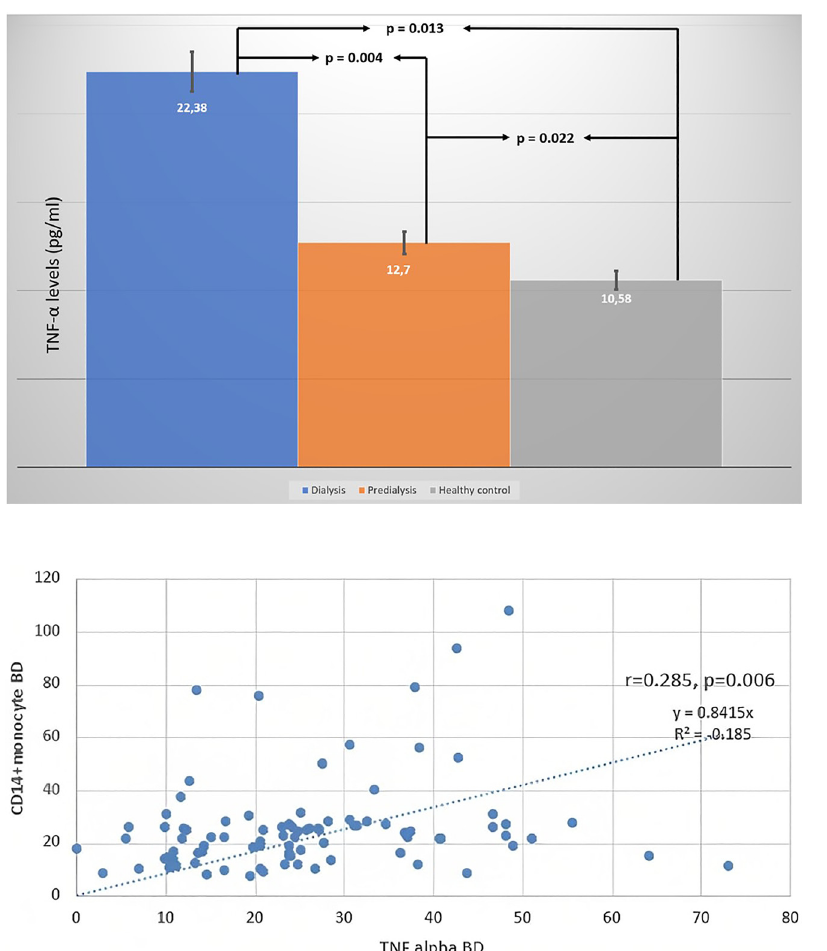
Figure 3: The correlation between serum TNF- α levels and classical monocyte subgroup.